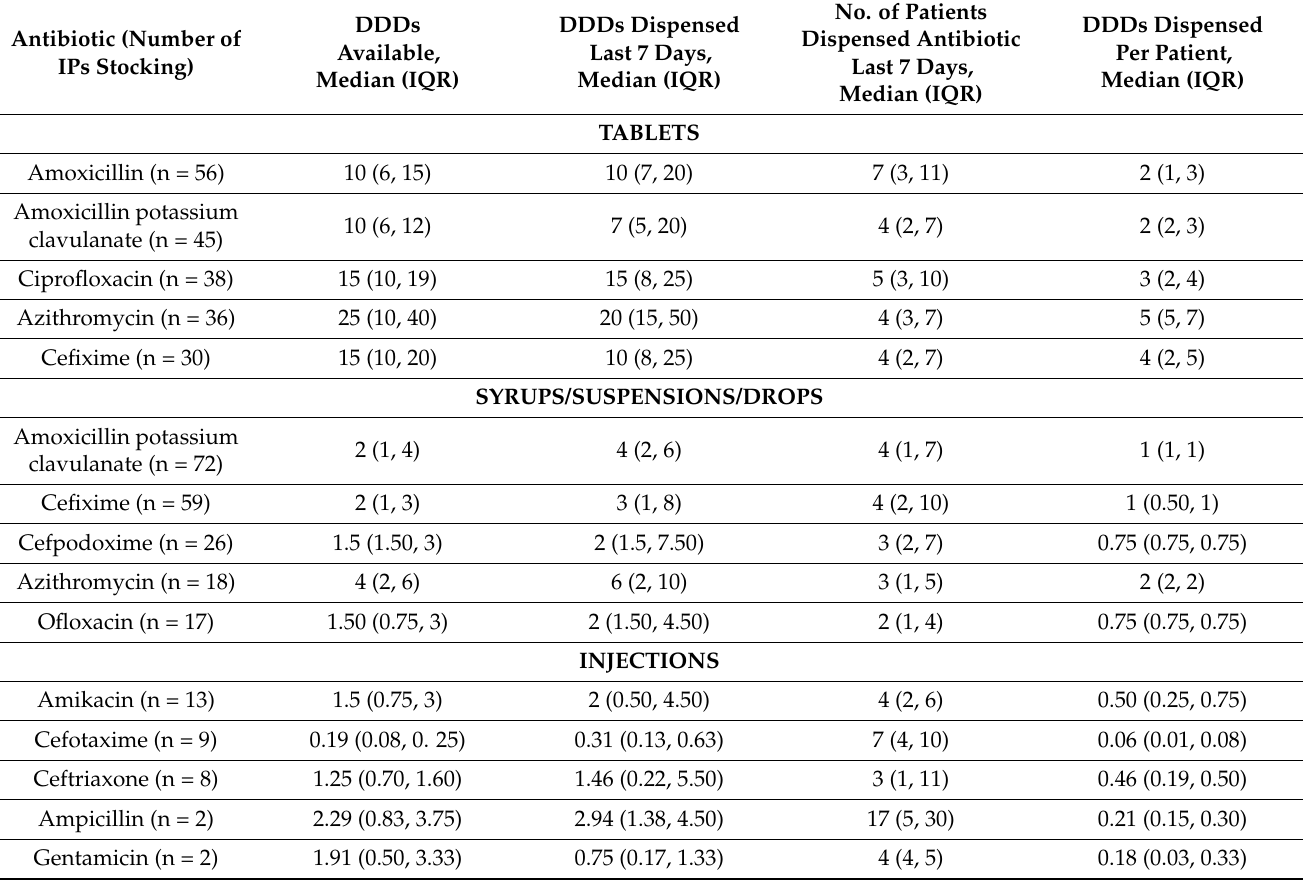
Table 3. DDDs available, DDDs dispensed in the last seven days * and numbers of patients dispensed * antibiotics for the top 5 antibiotics stocked by IPs, by formulation ( n =